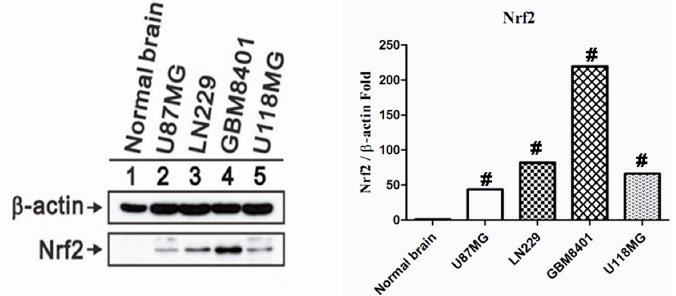
Figure 1. Nrf2 protein Expression in U87MG, LN229, GBM8401 and U118MG human glioma cell